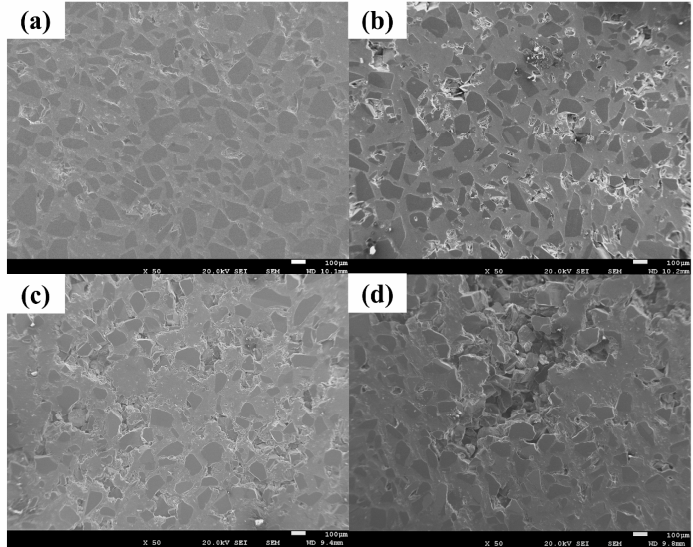
Figure 8. Representative SEM images showing the micromorphology of: ( a ) SiC/Al-12Si-Mg (62% SiC); ( b ) SiC/Al-7Si-Mg (62% SiC); ( c ) SiC/Al-12Si-Mg (56% SiC); ( d ) SiC/Al-7Si-Mg (56% SiC).